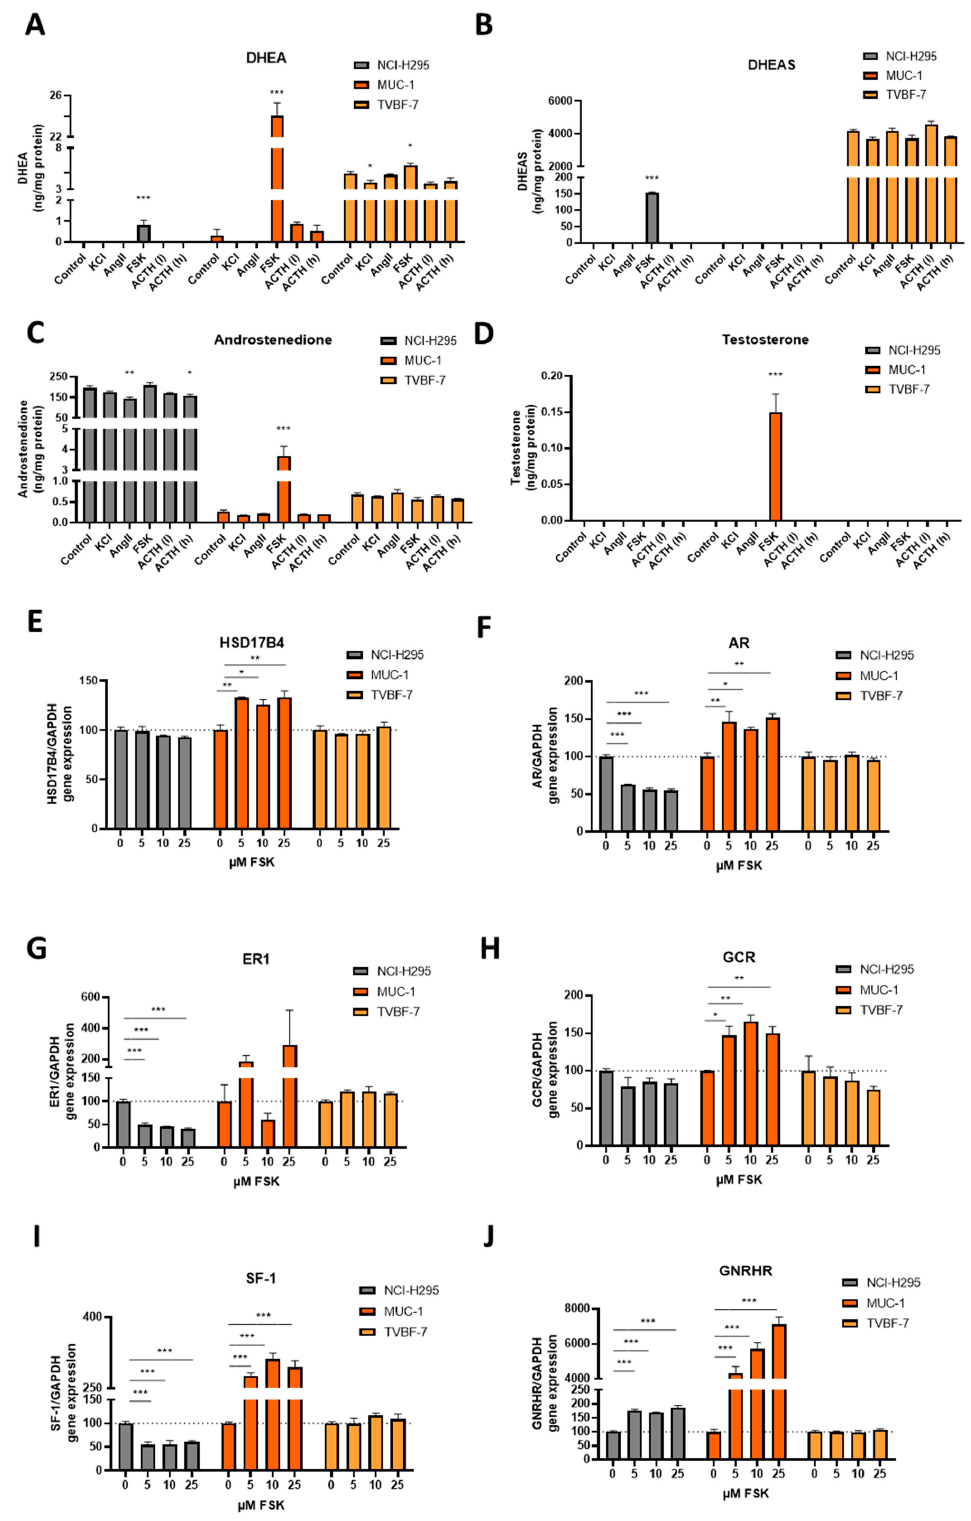
Figure 6. Androgenic pathway activation. Hormonal production of DHEA ( A ), DHEAS ( B ), An- drostenedione ( C ) and Testosterone ( D ) in ng per mg of total protein for unstimulated cells in comparison with KCl, AngII, FSK and two different ACTH stimulations. HSD17B4 gene expression upon FSK ( E ) per cell line. Differential response of different hormonal receptor expression per cell 36 line upon FSK stimulation: expression levels of AR ( F ), ER1 ( G ), GCR ( H ), SF-1 ( I ) and GNRHR ( J ) Stars represent significance vs. untreated cells (* p < 0.05; ** p < 0.01; *** p <